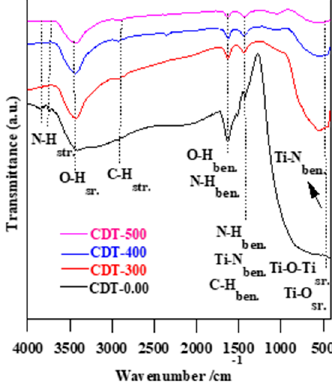
Figure 7. FT-IR of CDT-0.00, CDT-300, CDT-400, and CDT-500 samples. Table 3. The surface composition of Ti, O, C, and N obtained from Table 4. FTIR vibration bands and their locations for CDT-0.00, CDT-300, CDT-400, and CDT-500 samples.